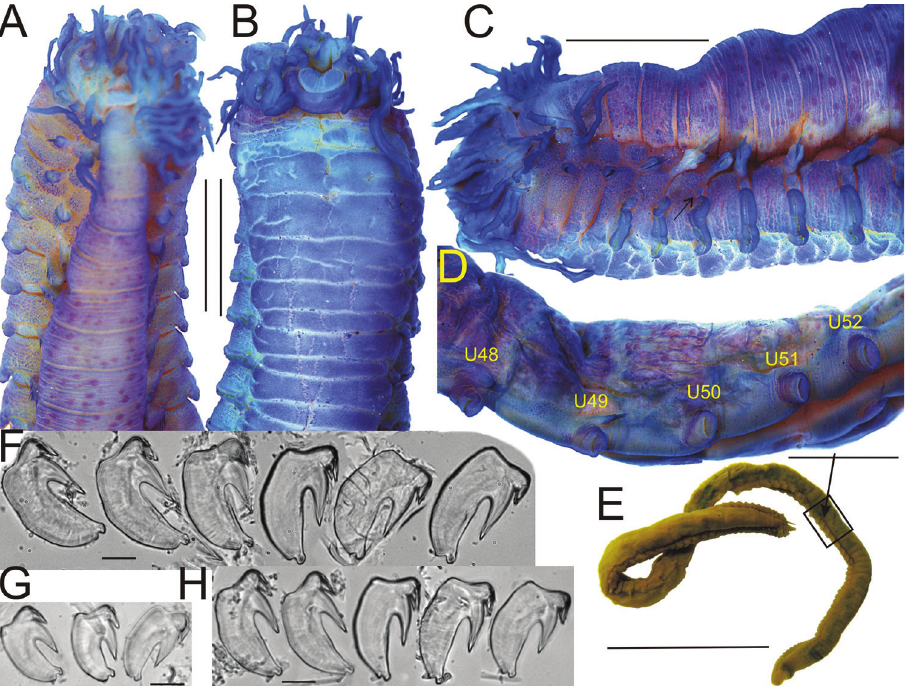
Figure 4. Thelepus davehalli sp. n . A–C anterior end: A dorsal view B ventral view C lateral view (arrowed nephridial papilla) D U48–U52 lateral view E – total view, rectangle shows position of D (arrow indicates last segment with notochaetae) F–H uncini: F, G U1 H U48, A–F, H Sevastopol st. 2587: A–E holotype F, H paratype G APEM 232335. All worms but E stained with methylene blue. Scale bars: 2 mm ( A–E ); 20 μm ( F–H